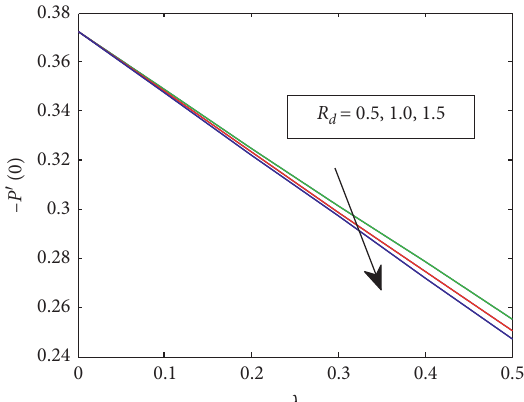
Figure 17: Concentration distribution for different values of mixed convection parameters.